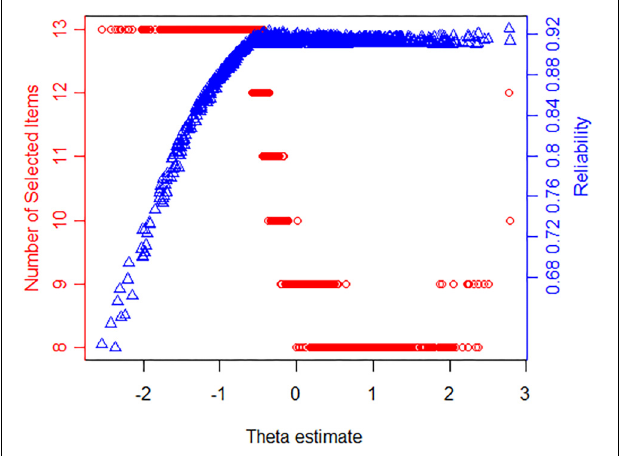
FIGURE 1 | The relationship among the latent stress ( θ ) estimate, reliability, and the number of selected items for the stopping rule SE( θ ) < 0.3 or length(item) = 13 (dots represent respondents; triangles show reliability).